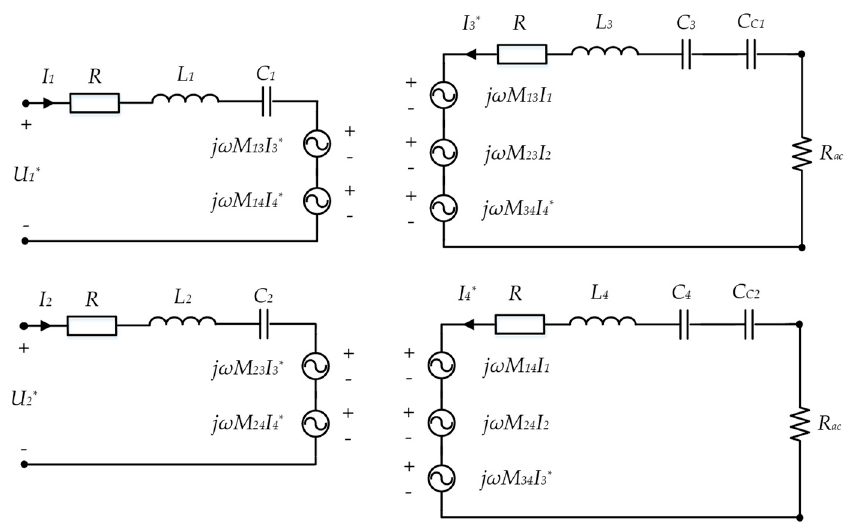
Figure 5. Equivalent circuit in case of adding canceling capacitors to reduce influence of mutual inductance between receivers.